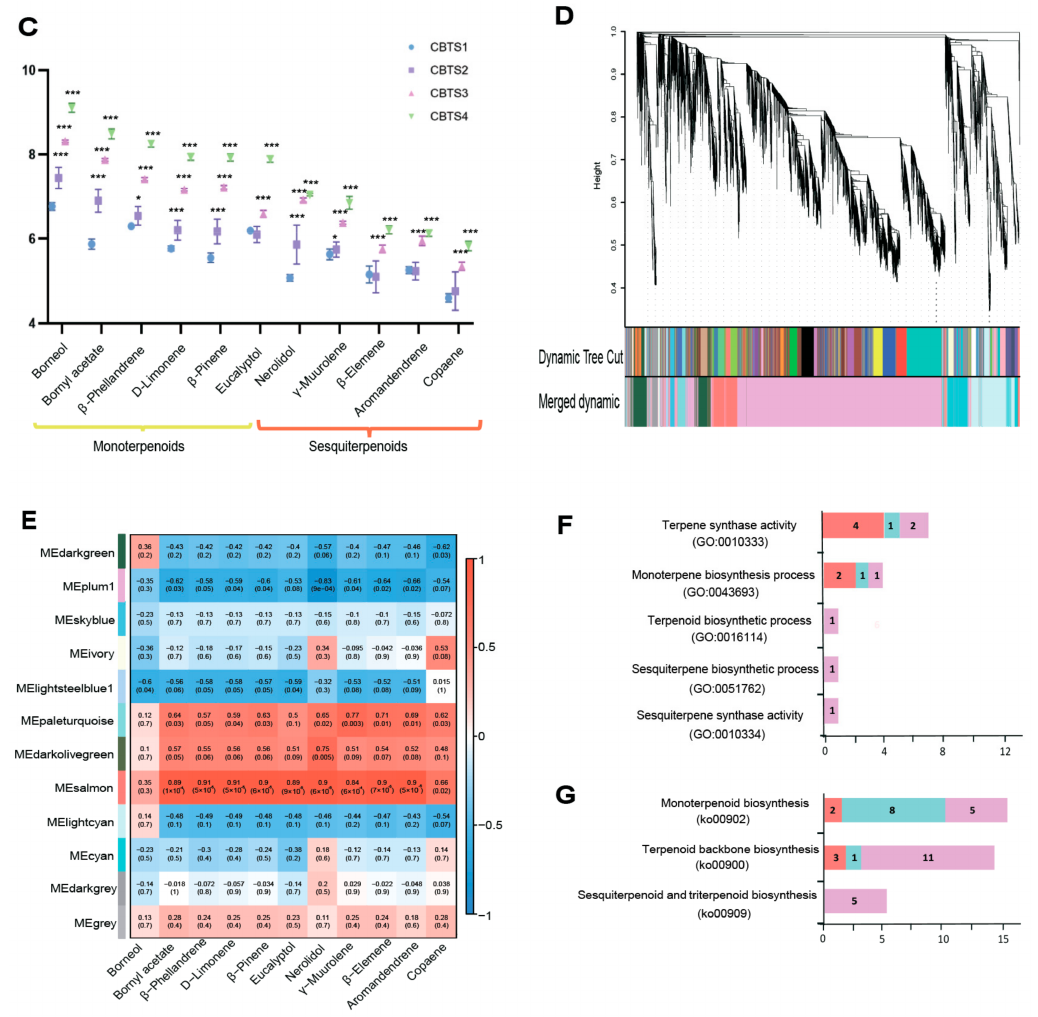
Figure 1. Detection of differentially expressed metabolites (DEMs) and their co-expressed genes across four developmental stages (CBTS1–4) of C. burmannii leaves. ( A ) PCA of 12 metabolite samples across the four developmental stages. ( B ) Venn diagram showing the overlapping DEMs between CBTS1 and CBTS3, between CBTS2 and CBTS4, and between CBTS1 and CBTS4. ( C ) Among the 67 overlapping DEMs mentioned above, the content of 11 most abundant terpenoids (six monoterpenoids and five sesquiterpenoids) significantly increased from CBTS1 to CBTS4. Symbols * and *** indicate the p values < 0.05 and <0.01, respectively using Student’s t -test analysis. ( D ) Hierarchical clustering of co- expressed genes shows the co-expression modules. Each branch in the phylogenetic tree corresponds to an individual gene, and the interconnected genes are grouped into twelve modules. ( E ) Heatmap based on gene expression patterns shows the module–metabolite relationships. The color bar shows the correlation between the twelve modules and six monoterpenes and five sesquiterpenes; blocks were colored in red and blue indicate positive and negative correlations. Numbers above represent correlation index between gene expression and abundance of terpenoids, and numbers below in brackets represent highly significant (Fisher’s exact test; p < 0.01), significant ( p < 0.05), and non- significant ( p ≥ 0.05) correlations. ( F ) Numbers of GO annotated genes in different models with the p -value < 0.05. The blocks in different color are corresponding to the modules detected in Section E. ( G ) Numbers of KEGG annotated genes in different models with the p -value < 0.05. The blocks in different color are corresponding to the modules detected in Section